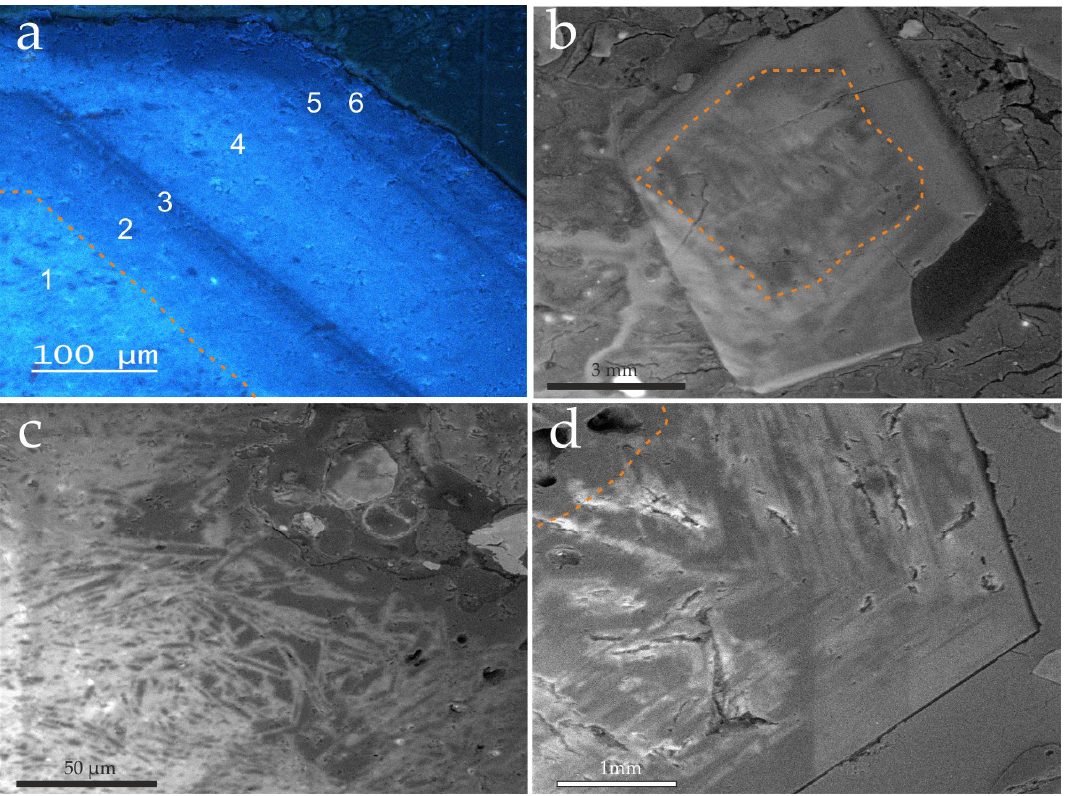
Figure 6. SEM-Cathodoluminescence (SEM-CL) analysis: ( a ) Light blue characterizes the luminescence response of the quartz crystals. Variation in the texture and color reveal changes between the center and the edges, separating the center, named silica nucleus (1) and five bands of quartz overgrowths (2–6); ( b ) The texture of the crystal reveal an irregular pattern in the center and a second phase of formation characterized by a regular overgrowth; ( c ) Detail of the center of the crystal (silica nucleus) showing quartz pseudomorphs after evaporite minerals (determined by SEM and microprobe analyses); the pseudomorphs appear either randomly oriented or subparallel to bedding; ( d ) The edges of the crystal appear as various bands, with variations in luminescence suggesting quartz overgrowth. To better distinguish textures, SEM-CL images are included in grey-scale colors.